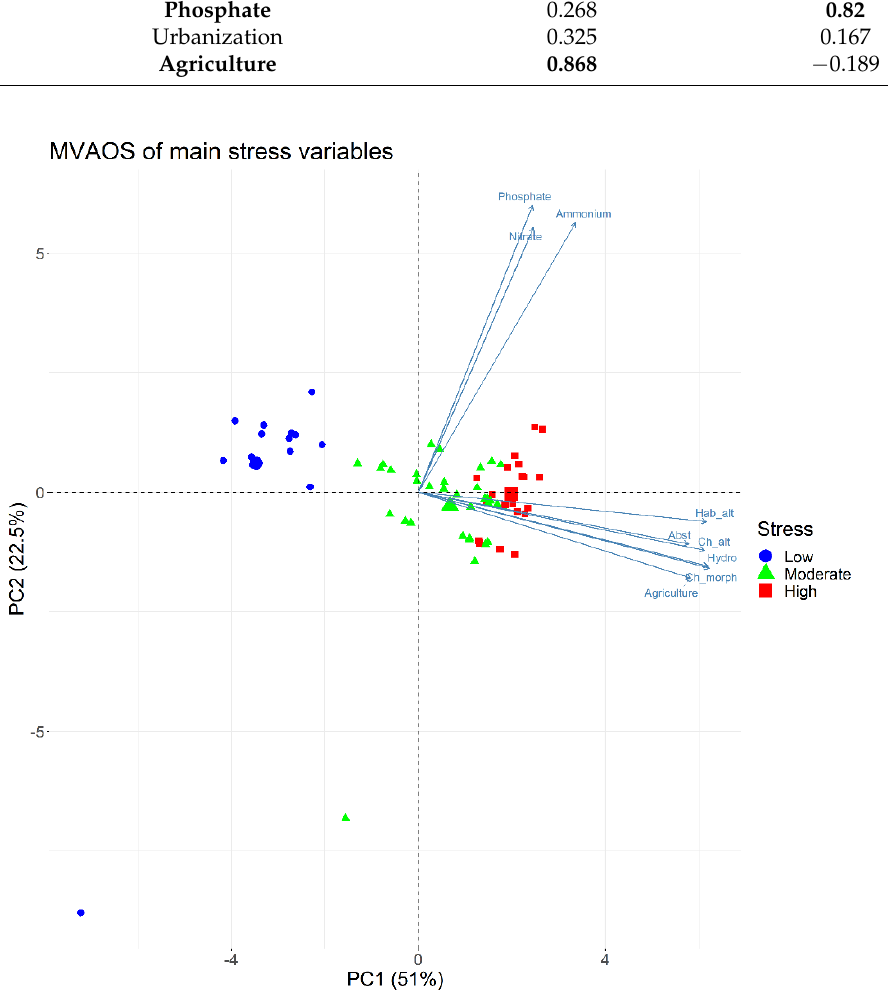
Figure 2. A MVAOS principal component analysis biplot with the nine most important environmental stressors. The position of the sites along the principal component 1 indicates the level or perturbation (stressed, moderately stressed and unstressed).